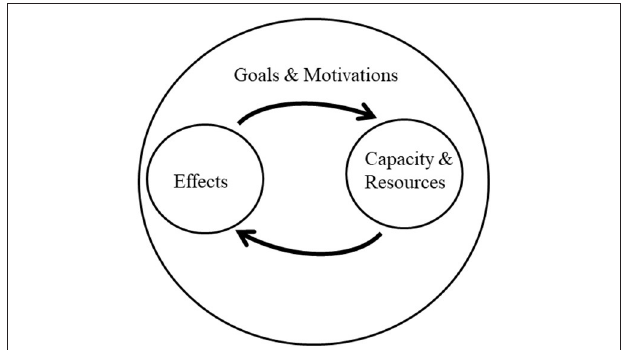
FIGURE 1 | Visual representation of the relationship between the capacities and resources that non-farmers have and the effects they hope to or can achieve. Goals and motivations form the backdrop onto which effects and resources mutually reinforce one another. Wisdom dialogues would be most impactful at the level of goals and motivations, thus changing the context in which effects and resources exist and affect one